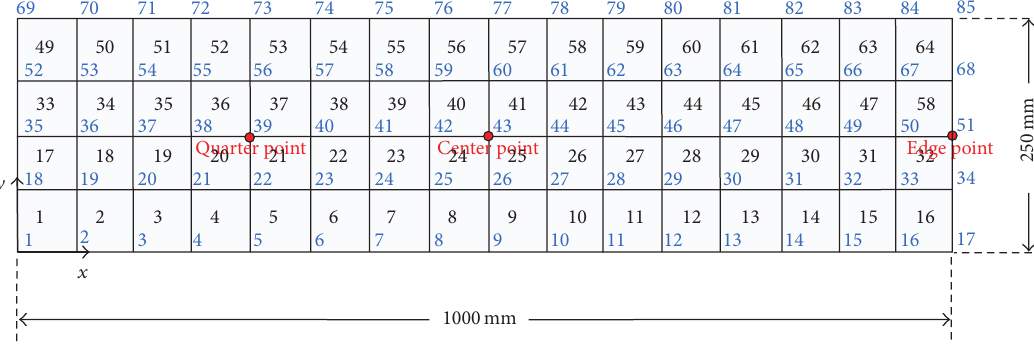
Figure 4: Nodes and elements in finite model of laminate plate.